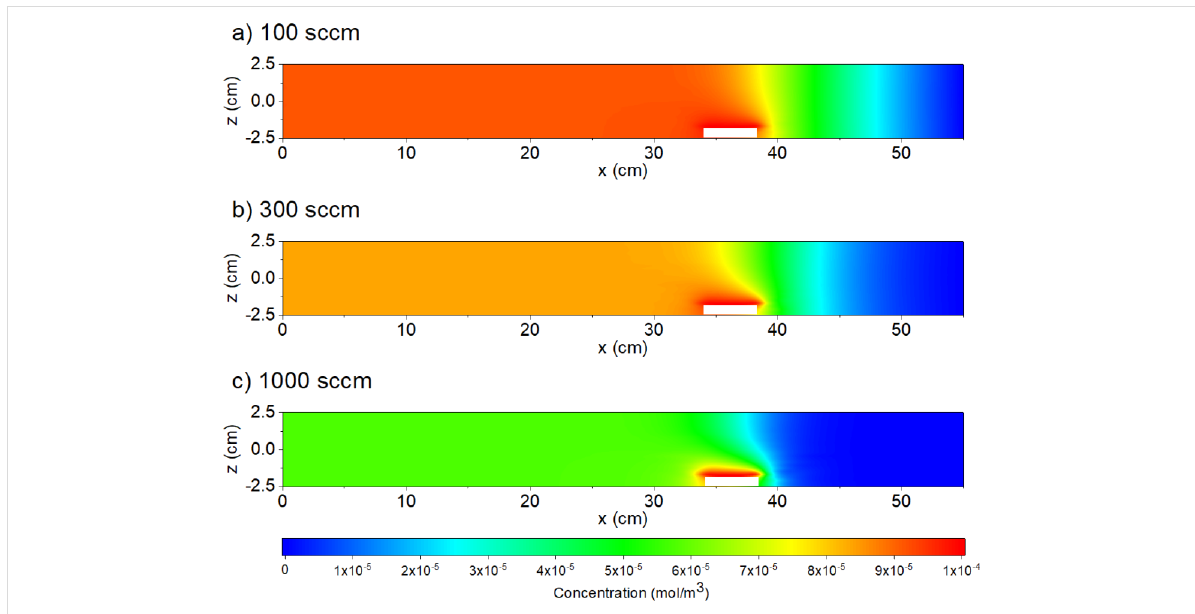
Figure 2: Influence of the total volumetric inflow on the stationary metal vapor concentration along the quartz tube: Simulated stationary vapor con- centrations for a total volumetric inflow (from the right) of (a) 100 sccm, (b) 300 sccm and (c) 1000 sccm. The simulated pressure is 1 bar. The white rectangles in the simulations represent the powder boat. The substrates are positioned in the homogeneous downstream-oriented